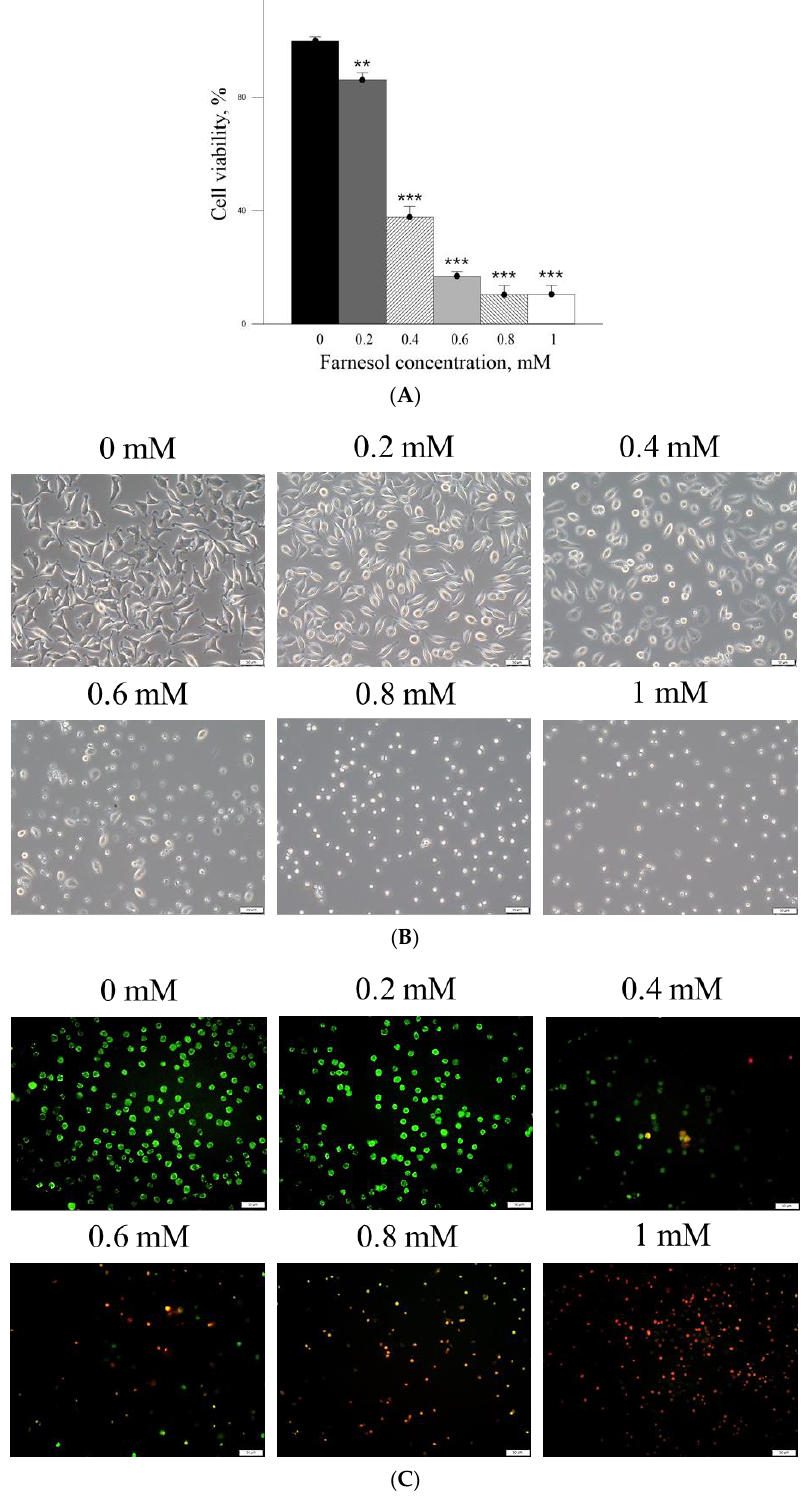
Figure 3. ( A ) MTT cell viability assay of pure Farn in L929 fibroblasts. ( B ) Cell morphology of L929 fibroblasts treated with different concentrations of pure Farn. ( C ) Live–dead staining of cells treated with pure Farn at different concentrations (green fluorescence, live cells; red fluorescence, dead cells). ** p < 0.01, *** p < 0.001, by analysis of variance compared with the control group (0 mM pure Farn). Bar: 50 µ